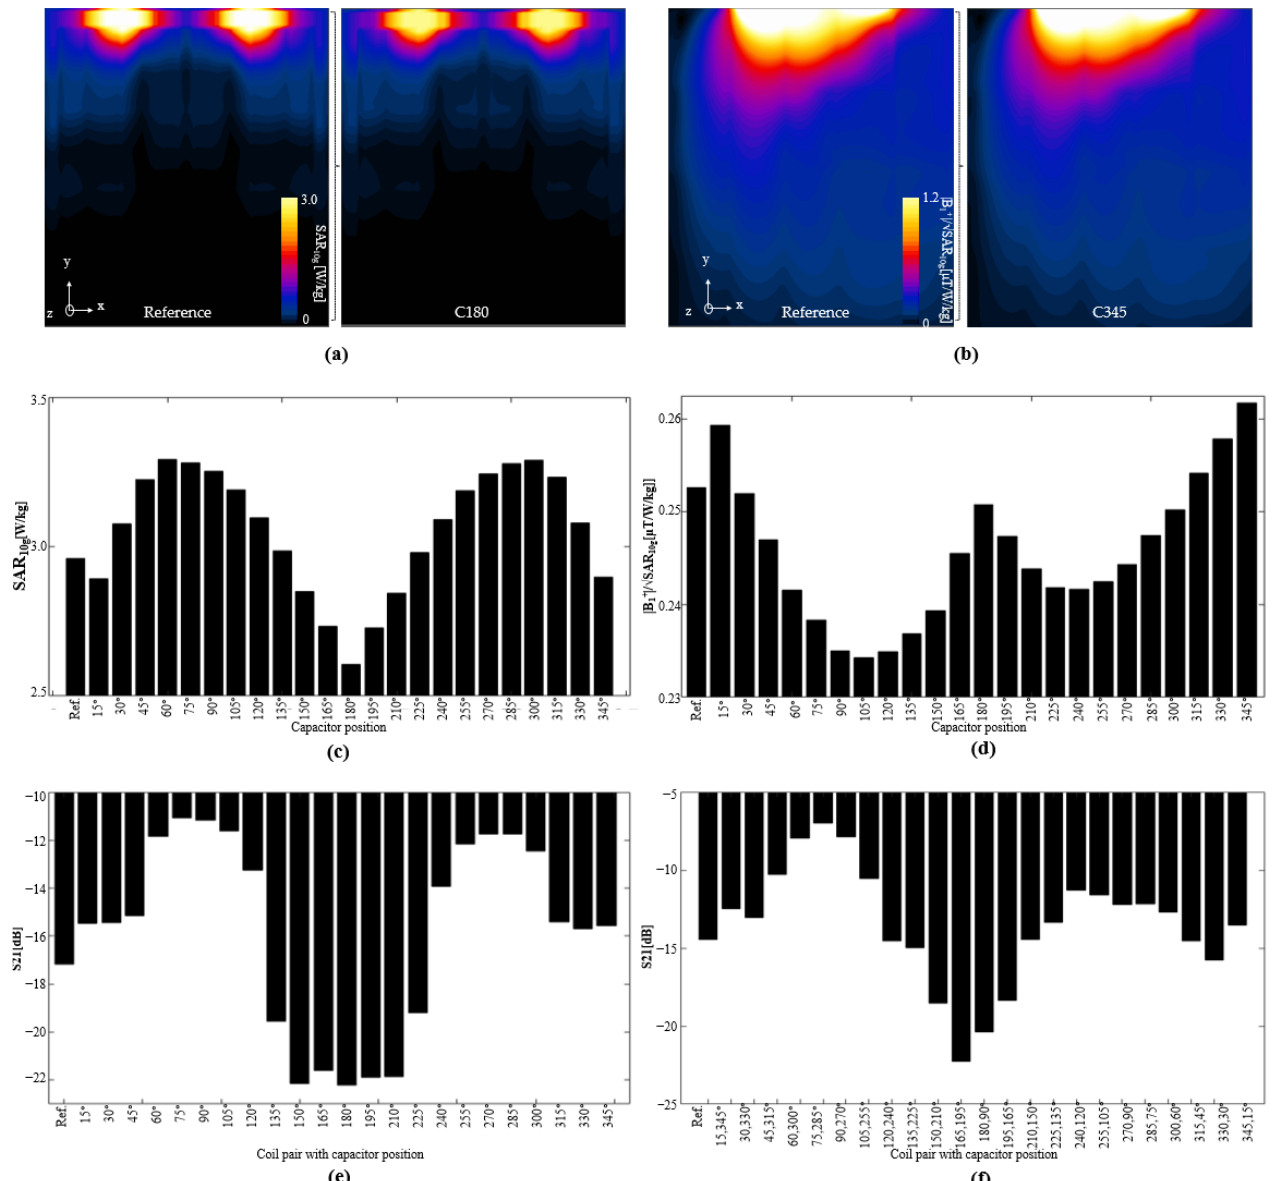
Figure 9. Computed SARs in XY plane for ( a ) reference coil, and coil with capacitor at position 180°. Normalized |B 1+ | field based on maximum SAR ( b ) for the reference coil and coil with capacitor at position 345°. ( c ) Maximum SARs in phantom for all tested coil configurations, and ( d ) mean values of normalized |B 1+ |/SAR max field for all tested coil configurations. Coupling analysis of S 21 parameters for ( e ) coils with identical configurations, and ( f ) coils with opposite capacitor configurations.